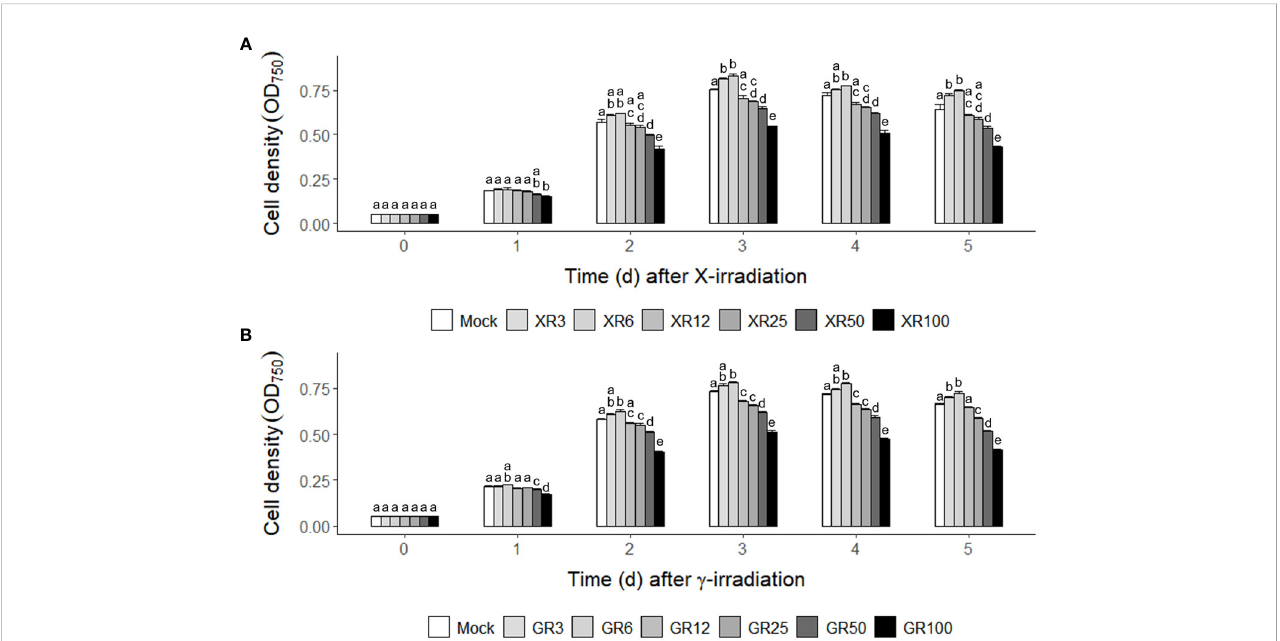
FIGURE 1 Counterintuitive dose-responses of X- or g -irradiation in the cultivation of C. reinhardtii cells. (A) X-irradiation; (B) g -irradiation. XR3 (GR3), XR6 (GR6), XR12 (GR12), XR25 (GR25), XR50 (GR50), and XR100 (GR100) represent X-rays ( g -rays) of 3, 6, 12, 25, 50, and 100 Gy, respectively. Mid-exponential phase C. reinhardtii cells were differentially subjected to X- or g -irradiation to have the absorbed doses of 3, 6, 12, 50, and 100 Gy as described in the Materials and Methods section. The cell densities were compared by measuring the optical density at 750 nm (OD 750 ) to evaluate the growth rates of mock and irradiated cells. Data represent the mean ± standard error (SE) with n = 9 from three independent experiments. Different letters indicate signi fi cant differences at p < 0.05 (one-way analysis of variance followed by Tukey ’ s honestly signi fi cant difference